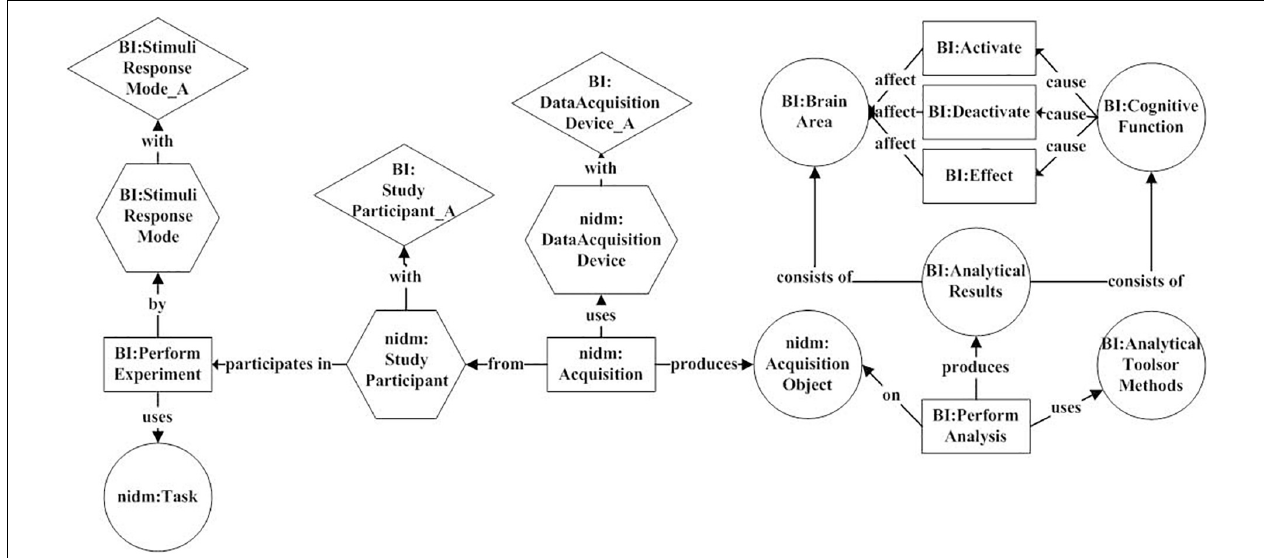
FIGURE 3 | The BI provenance model. It uses six activities (rectangle), including “BI:PerformExperiment,” “nidm:Acquisition,” “BI:PerformAnalysis,” “BI:Activate,” “BI:Deactivate,” and “BI:Effect” to characterize experimental design, analytical process, and results. Six entities (circle), three agents (hexagon), and three attributes (diamond) are connected to these activities for describing various key factors in the research